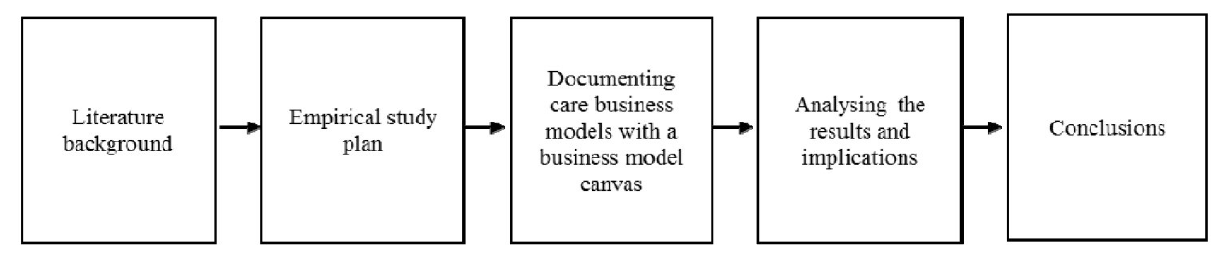
Figure 1. Research